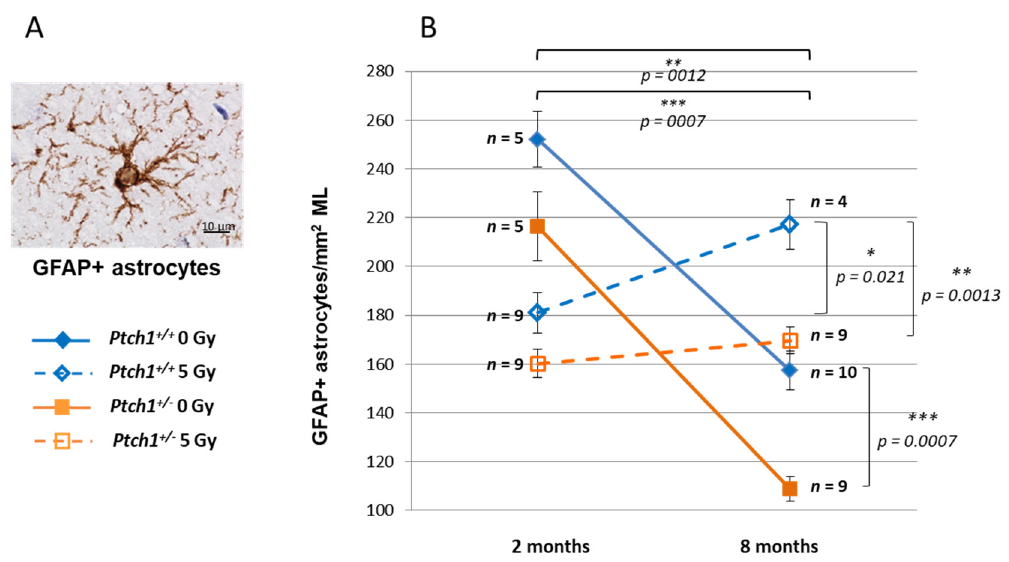
Figure 2. Long-term effect of irradiation with 5 Gy of X-rays at P10 in astrocytes in WT and Ptch1 +/ − mice at 2 or 8 months post-irradiation. ( A ) Representative immunostaining image of GFAP+ astrocytes in the molecular layer (ML) of the hippocampus. ( B ) Astrocyte quantification in unirradiated and irradiated WT and Ptch1 +/ − mice. Image, 100× magnification, scale bar = 10 µm. The number of mice used per test is indicated with n in the graphs. Data are reported as mean ± SEM * p < 0.05 ** p < 0.01; *** p < 0.001 for comparison with controls (Student t -test).